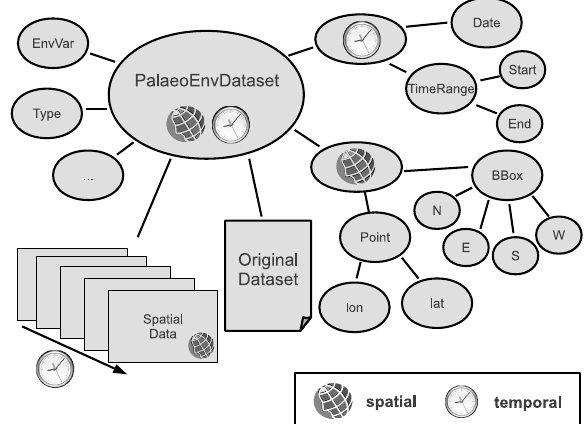
Figure 3: Generalized graph representation of the palaeoenviron- mental data model and also simplified versions of the temporal and spatial